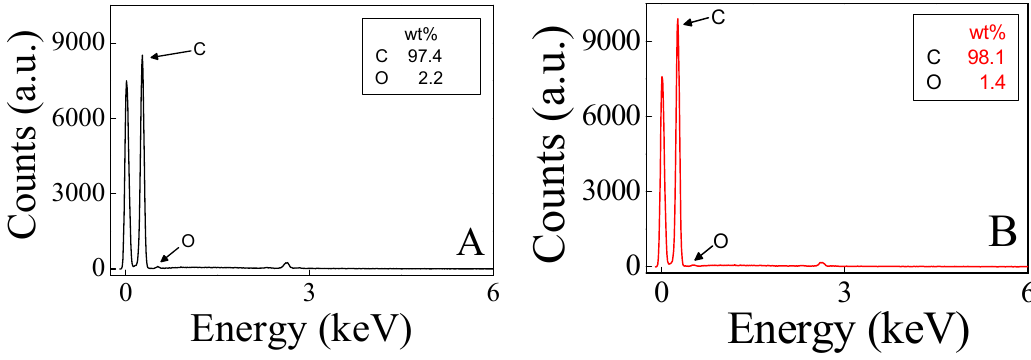
Figure 4. Differential Pulse Voltammograms data for individual electrooxidation of hydroquinone in ( A ), catechol in ( B ) , and BPA in ( C ) , using flexible SPEs after electrochemical pre-treatment.